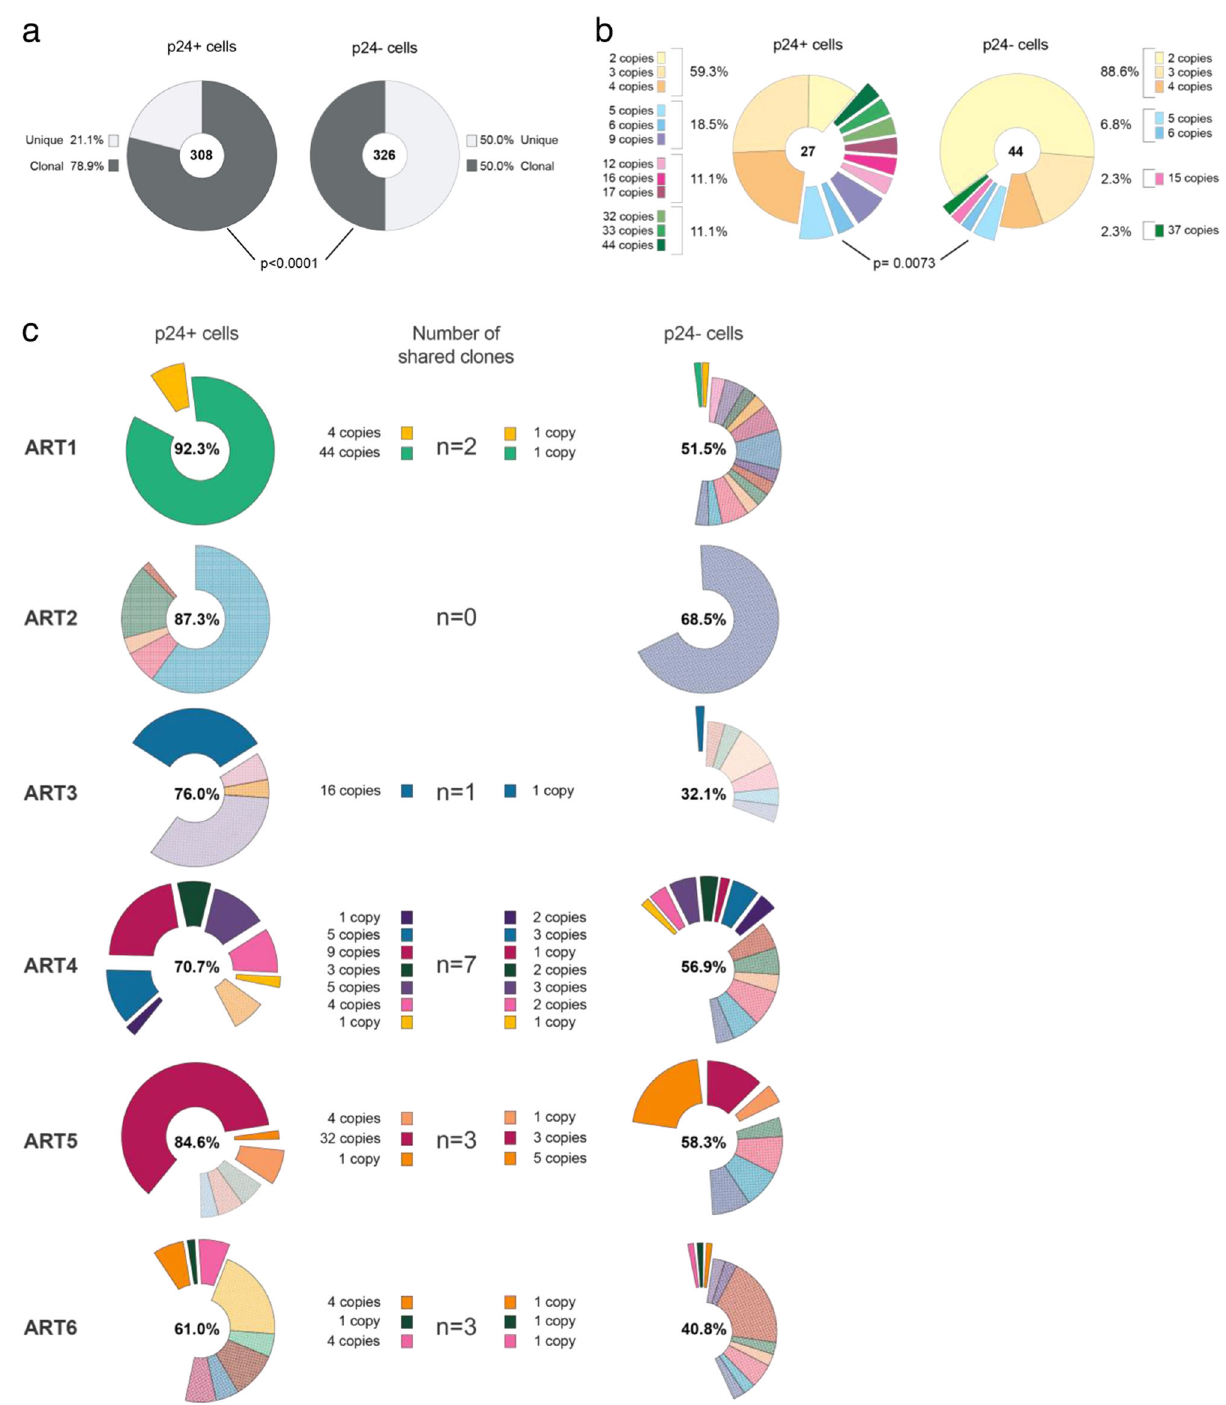
Fig. 3 | Clonality of the inducible and non-induced reservoirs. a Pie charts representing the proportions of unique (light grey) and clonally expanded (i.e., ≥ 2 copies, dark grey) proviruses in the p24+ and p24 − populations from the 6 parti- cipants. Two-sided Fisher ’ s exact test ( p <0.0001) of the contribution of clonally expanded proviral sequences to the total number of HIV genomes was performed between the two populations. The numbers of HIV genomes are indicated in each piechart. b Distributionsofclonalexpansionsfromthe6participants.Proportions of clones according to their size are represented for each cell population, with the total number of clonal expansions indicated in the pie charts. Difference in the